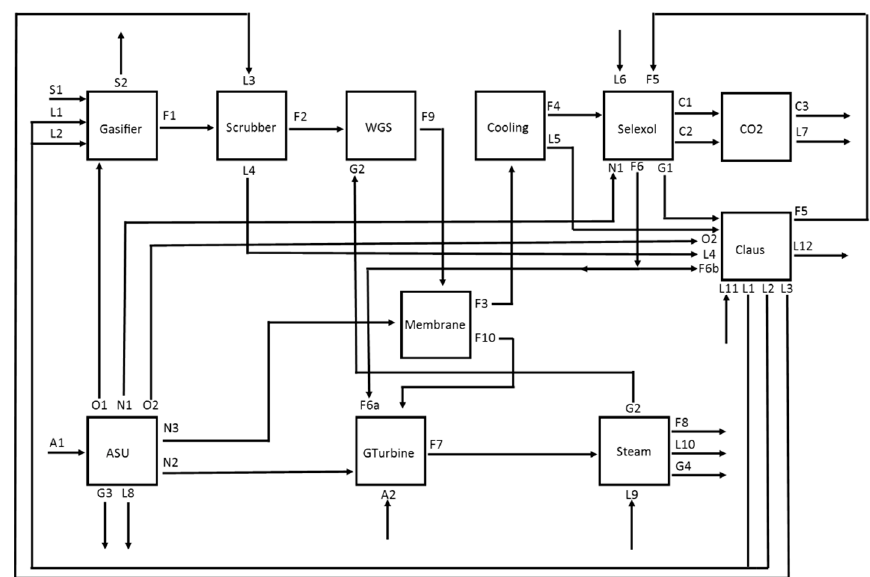
Figure 2. Hydrogen membrane model process flow diagram.